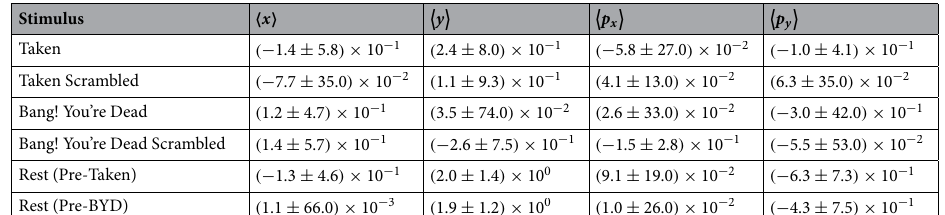
Table 1. Group averages of the centroids. Significant differences are only noted for the rest acquired before Taken and Bang! You’re Dead when comparing the average y location to either of their task counterparts (scrambled and intact stimulus).